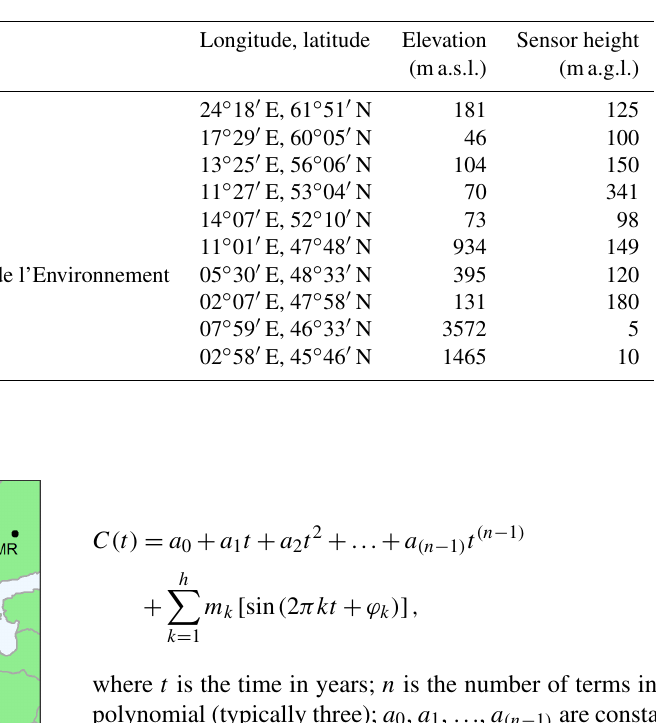
Table 1. The 10 monitoring stations used in the analysis from northernmost to southernmost. The ending date is 27 September 2020 in all cases.